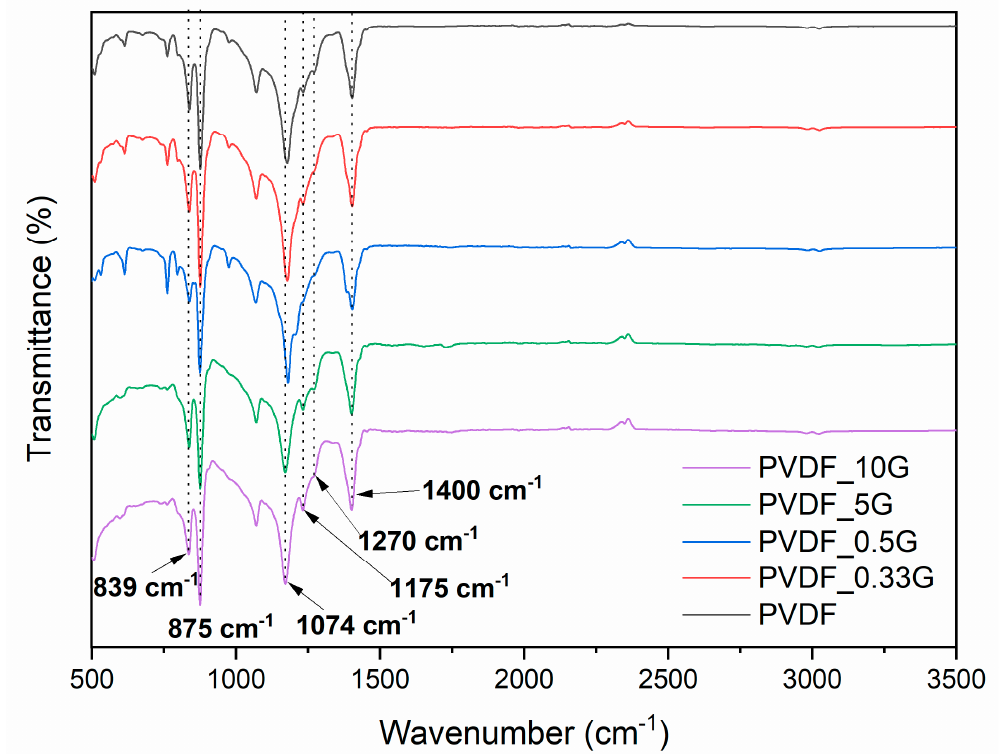
Figure 3. FTIR spectra comparison for pristine PVDF membrane and its graphene-based composites. XRD analyses revealed the presence of the filler inside the membranes (Figure 4). The (002) and (004) peaks at 26.5 ◦ and 54.6 ◦ , respectively, represent the perpendicular direction (c-axis) to the hexagonal planes of graphite [34]. They were detected in GNP material as well as in PVDF/GNP membrane patterns, and their intensity increased with raising concentration as an effect of GNP confinement in the polymer matrix. The rest of the signals in nanocomposite membranes were from the PVDF crystalline phase. For example, medium reflections at 18.4 ◦ and 20 ◦ , and a weaker one at 35.9 ◦ , correspond to the reflections of 020, 110, and 200 of monoclinic α -phase crystal, respectively, while the peak at 39.1 ◦ refers to diffraction peak on the(211) planes of monoclinic γ -phase crystal [35].